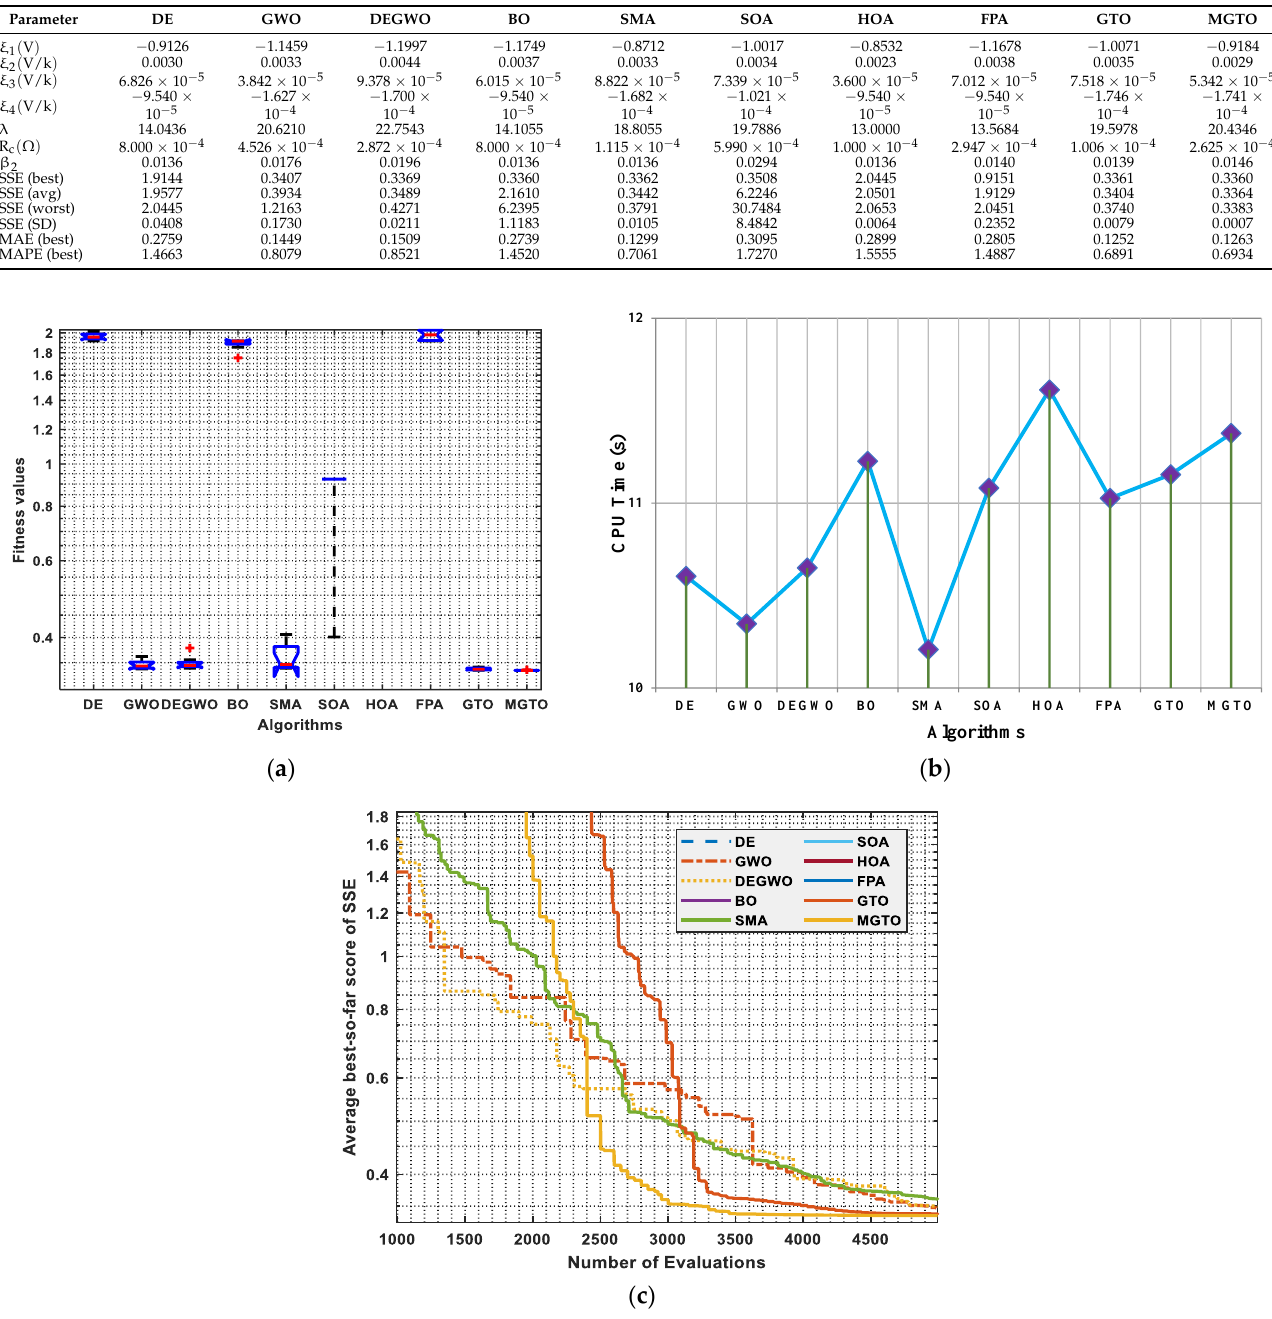
Figure 6. Comparison among algorithms in terms of five-number summary (boxplot), convergence speed, and CPU time on test case 2: ( a ) boxplot of the obtained outcomes, ( b ) CPU time, ( c ) convergence curve.